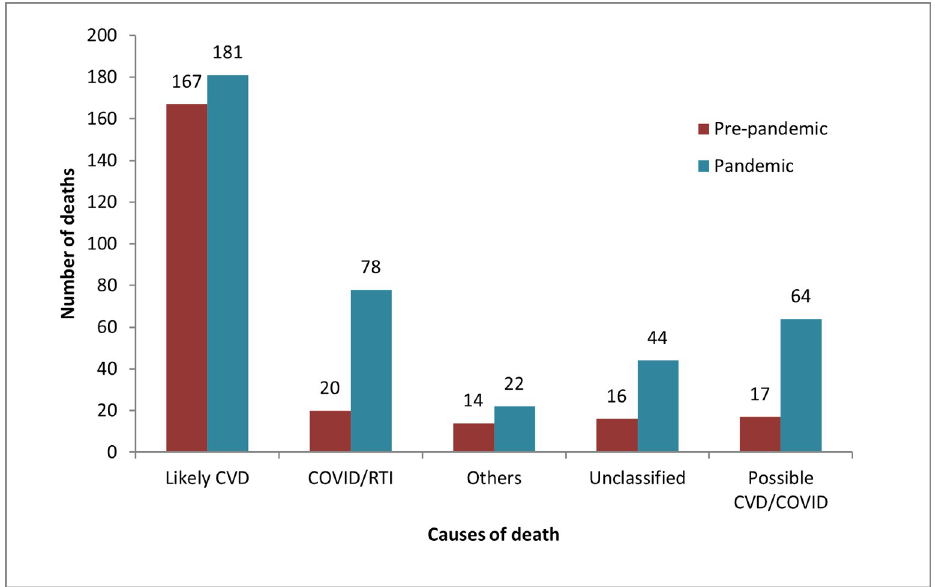
Fig 4. Comparison of causes of DOA between pre-pandemic vs. pandemic